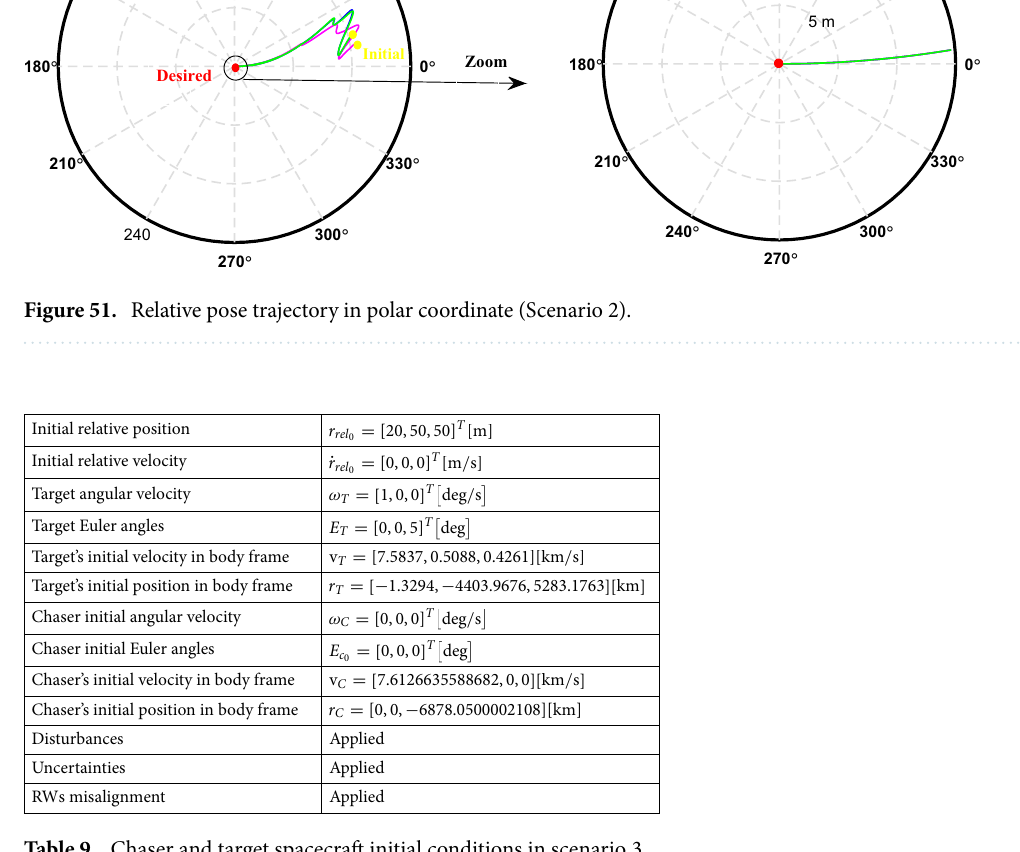
Table 9. Chaser and target spacecraft initial conditions in scenario